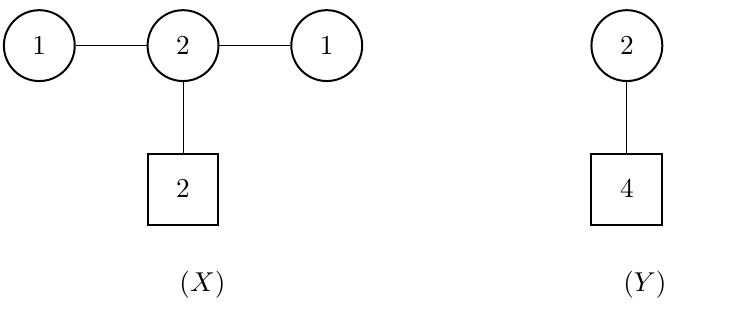
Figure 6 . An example of a pair of linear quivers with unitary gauge groups which are 3d mirrors.